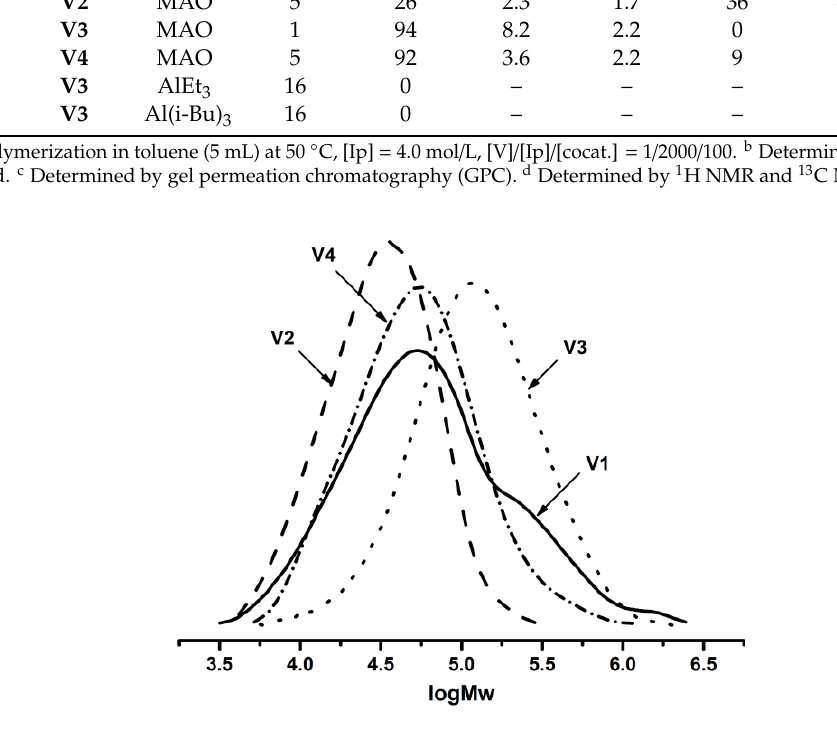
Figure 2. GPC curves of polyisoprene obtained using V1 – V4 / MAO catalyst system (Table 2, entry 1 − 4). Table 2. Effects of catalyst and cocatalyst by iminopyridine vanadium complexes a.